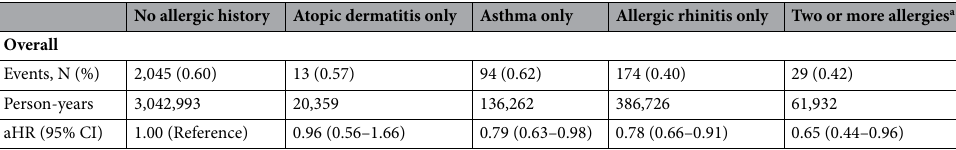
No allergic history Atopic dermatitis only Asthma only Allergic rhinitis only Two or more allergies